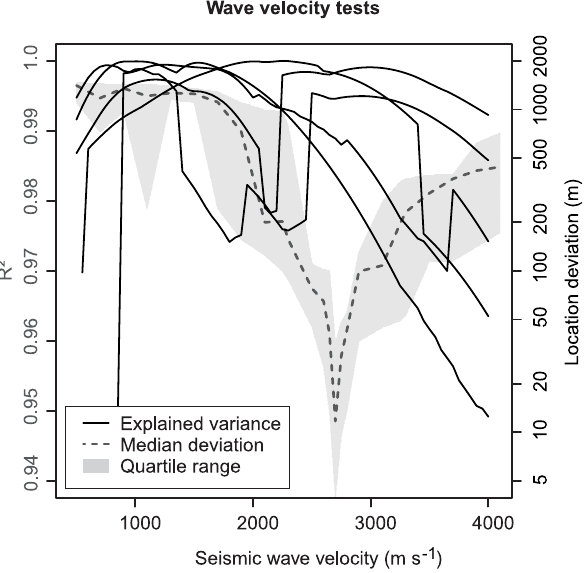
Figure 7. Tests of the most likely average value for the seismic wave velocity. Black solid lines show location approach correlation coefficient (average of all R 2 ) for velocity values ranging between 700 and 4000ms − 1 for all events that reached an R 2 > 0 . 94. The dashed grey line (median) and shaded area (interquartile range) de- pict deviation of seismically detected from TLS-based event loca- tions. Both measures point at 2700ms − 1 as the most likely average seismic wave velocity in the study area. The secondary R 2 maxi- mum at lower velocities did not yield locations inside the area of interest despite high R 2 values.